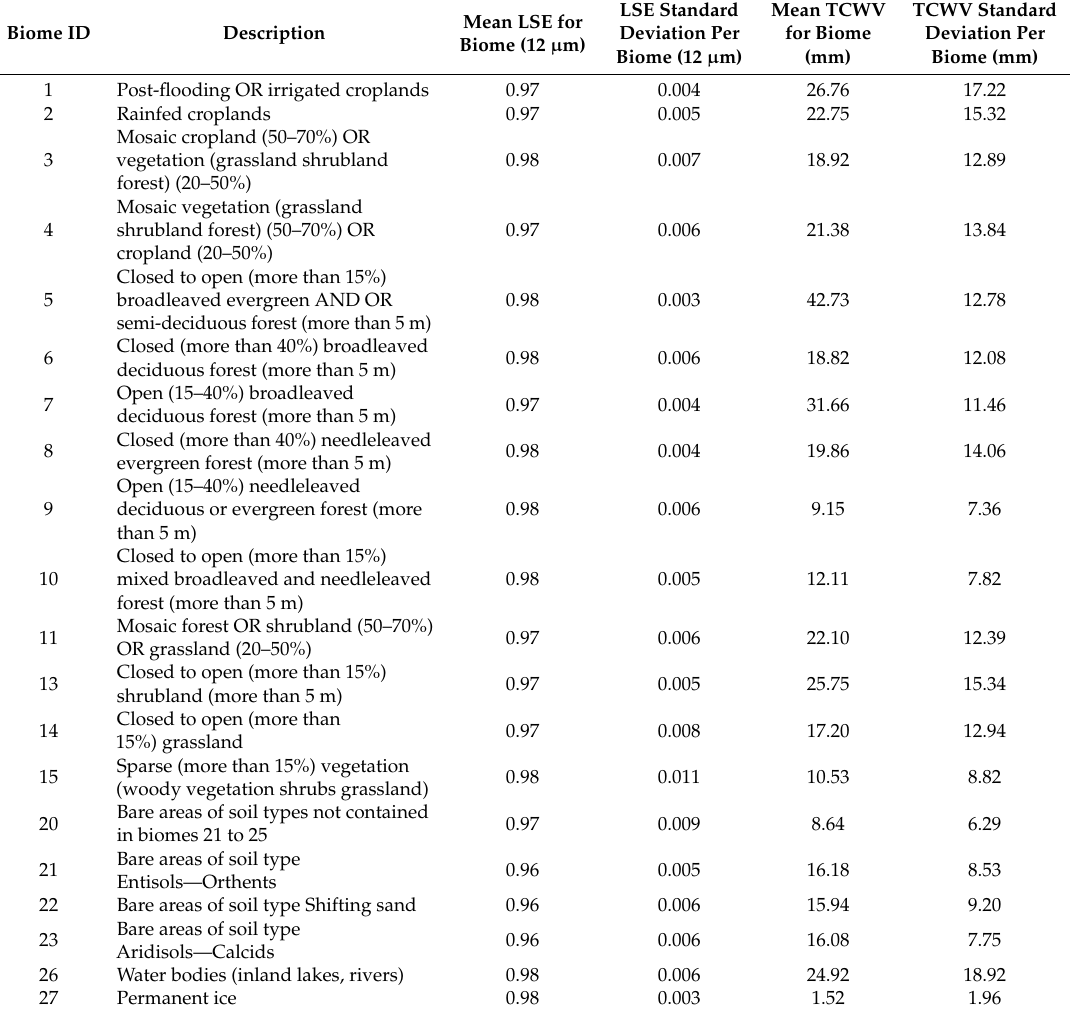
Table 3. Mean and standard deviations for LSE and TCWV for the biomes used in the sensitivity study. LSE values calculated from the CAMEL database, TCWV values from the ERA 5 profile data for 2013. Biome